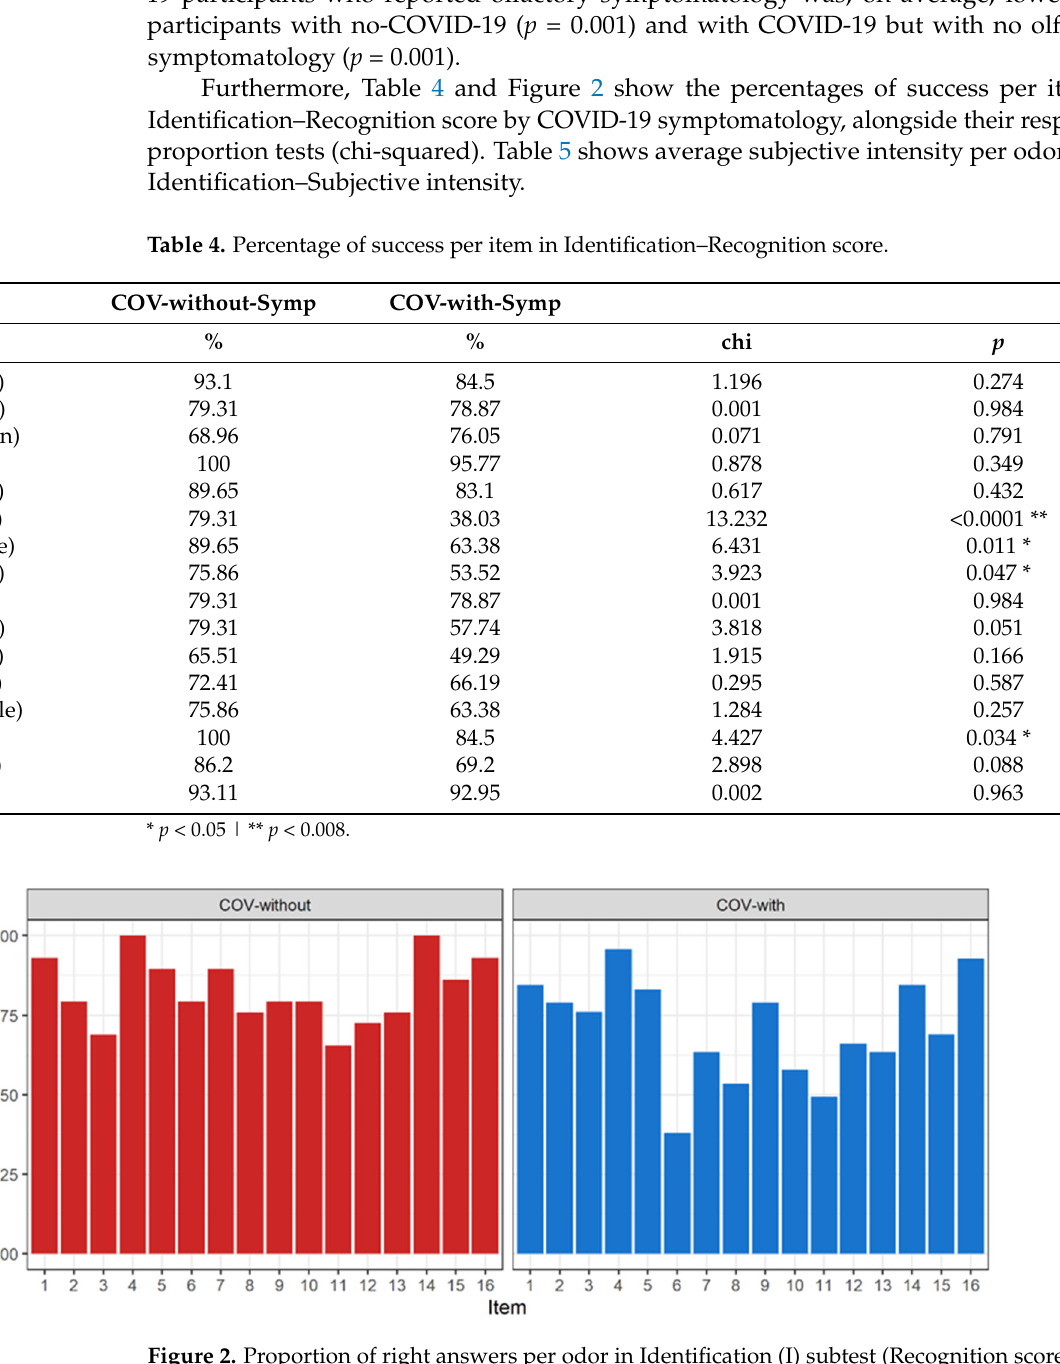
Figure 2. Proportion of right answers per odor in Identification (I) subtest (Recognition score). Proportion of right answers is statistically higher in the non-olfactory COVID-19